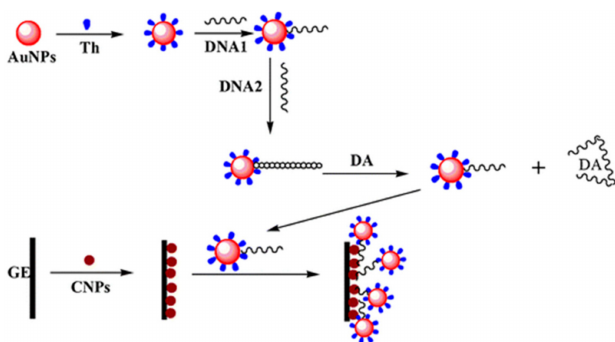
Figure 7. The schematic illustration of the aptamer-based dopamine sensor. Reprinted with permission from [80].